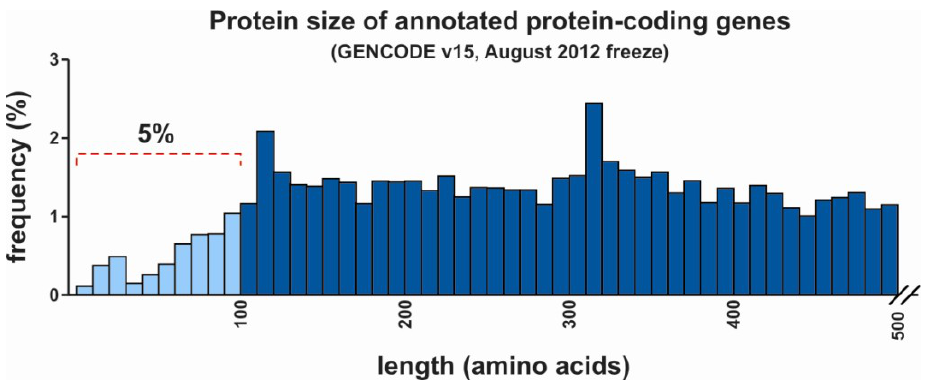
Figure 1. Size distribution of human proteins. Out of all annotated proteins derived from the protein-coding gene list in the GENCODE database (version 15, August 2012 freeze, GRCh37—Ensembl 70), five percent are less than 100 amino acids in size (1,039 out of 20,640). In this analysis, only the largest protein size was included when multiple isoforms were listed for a single gene